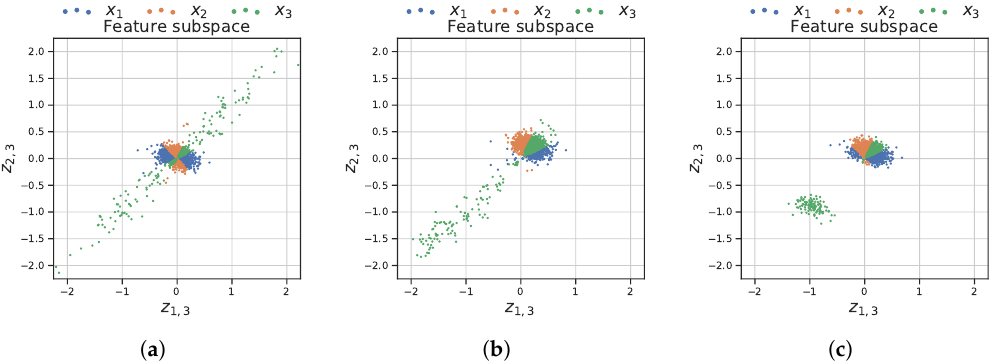
Figure 13. Root Cause Analysis: The samples in the feature subspace are colored by guilty index. It is clear the simplicity and the effectiveness of the proposed method. ( a ) Precision degradation fault. ( b ) Complete failure fault. ( c ) Bias